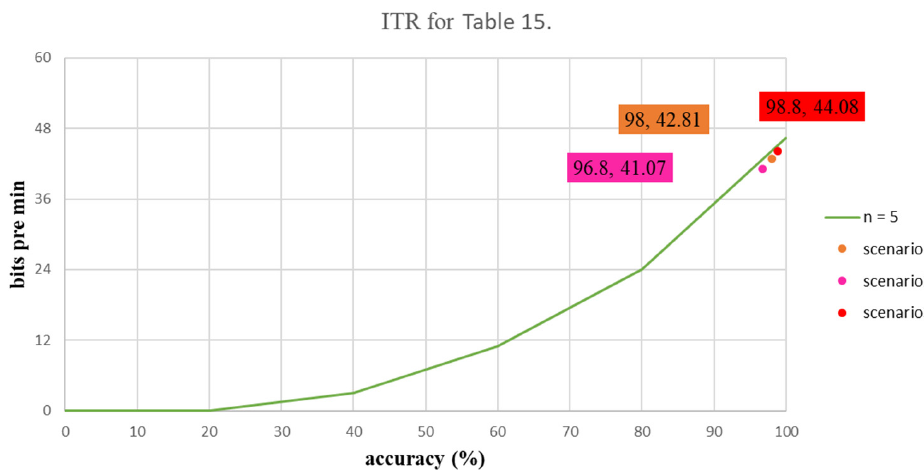
Figure 11. The ITR value for each stimulus using MR goggles.